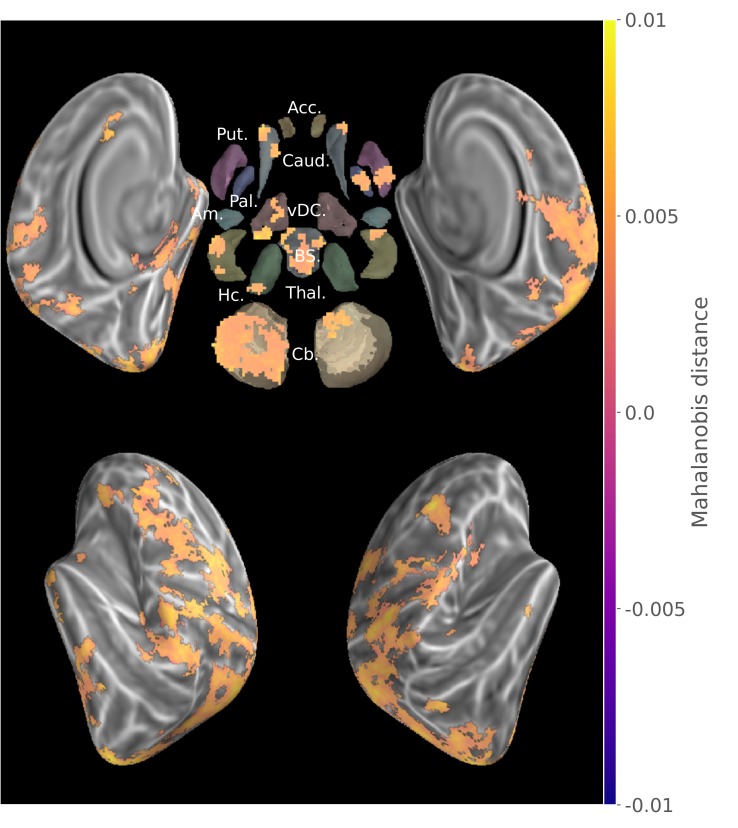
Group searchlight map of cross-validated Mahalanobis distance between the two new sequences (z-score thresholded at p < .05 TFCE-cluster-corrected).